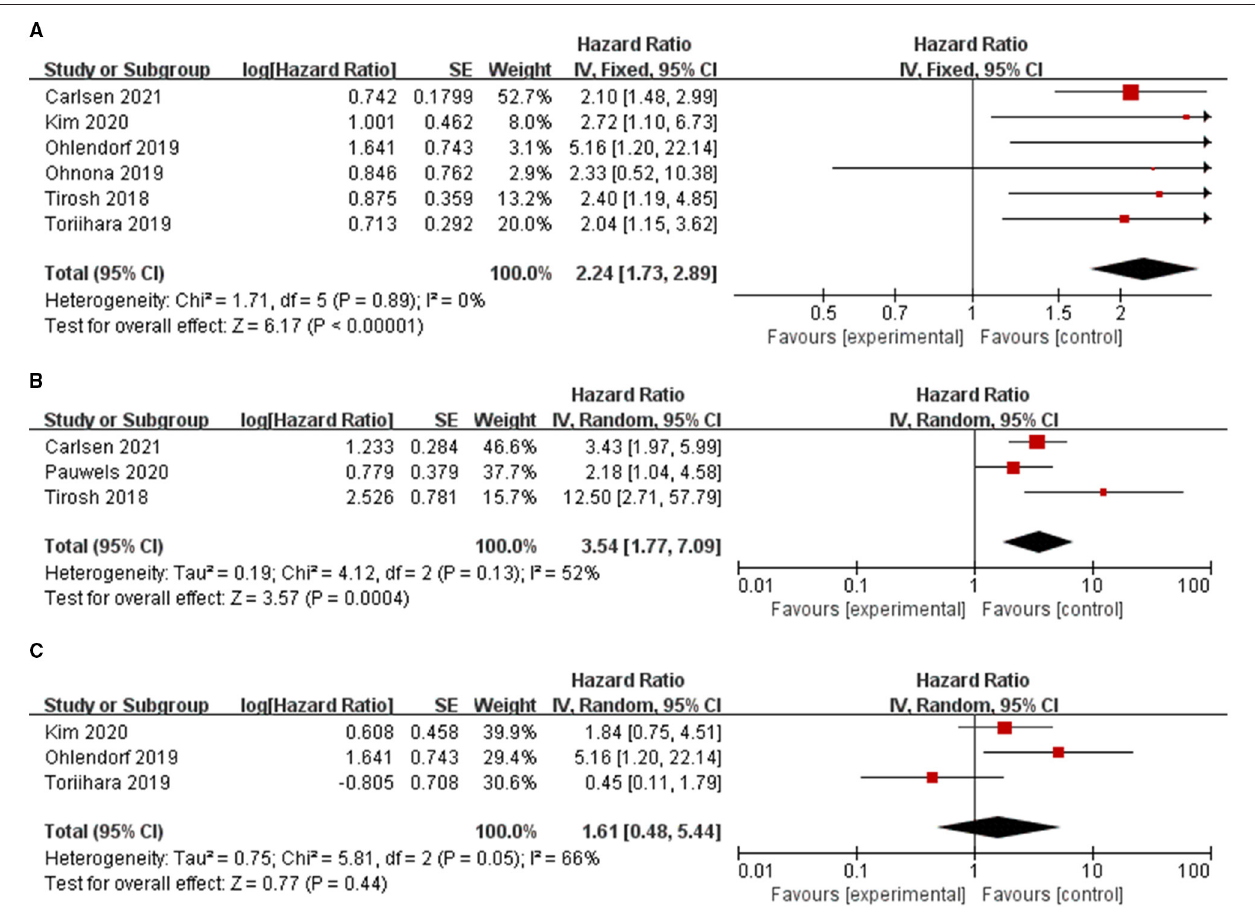
FIGURE 2 | Forest plot results of the PFS (A) and OS (B) based on the total tumor volume and PFS based on the total tumor expressing SSTR (C) .